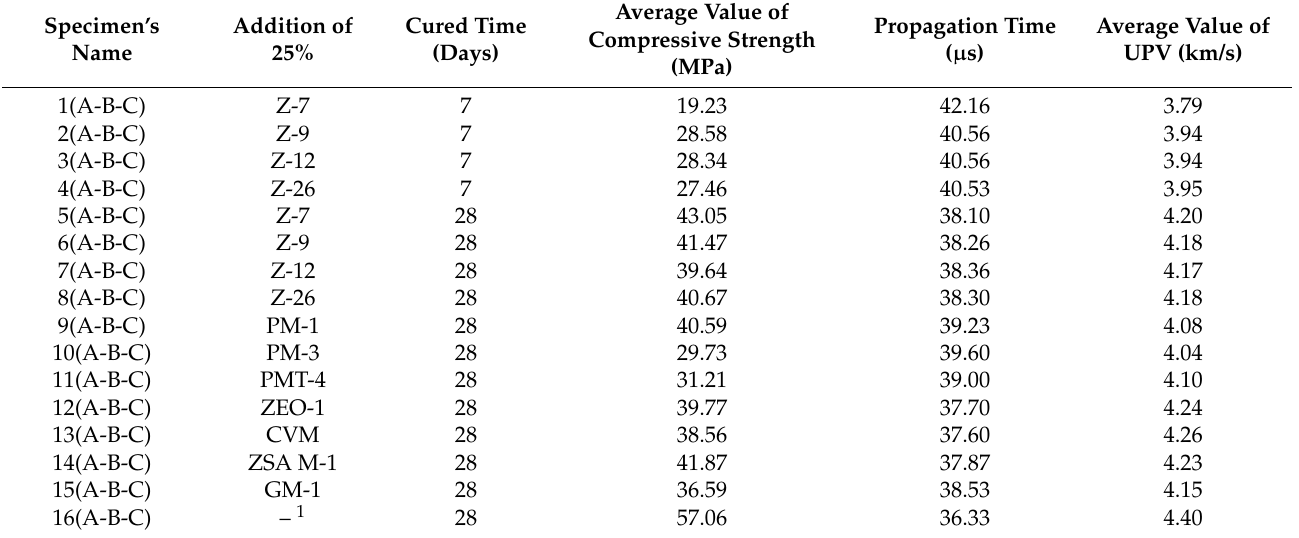
Table 2. Results obtained for specimens prepared with the mixtures in the compression resistance and ultrasonic pulse velocity